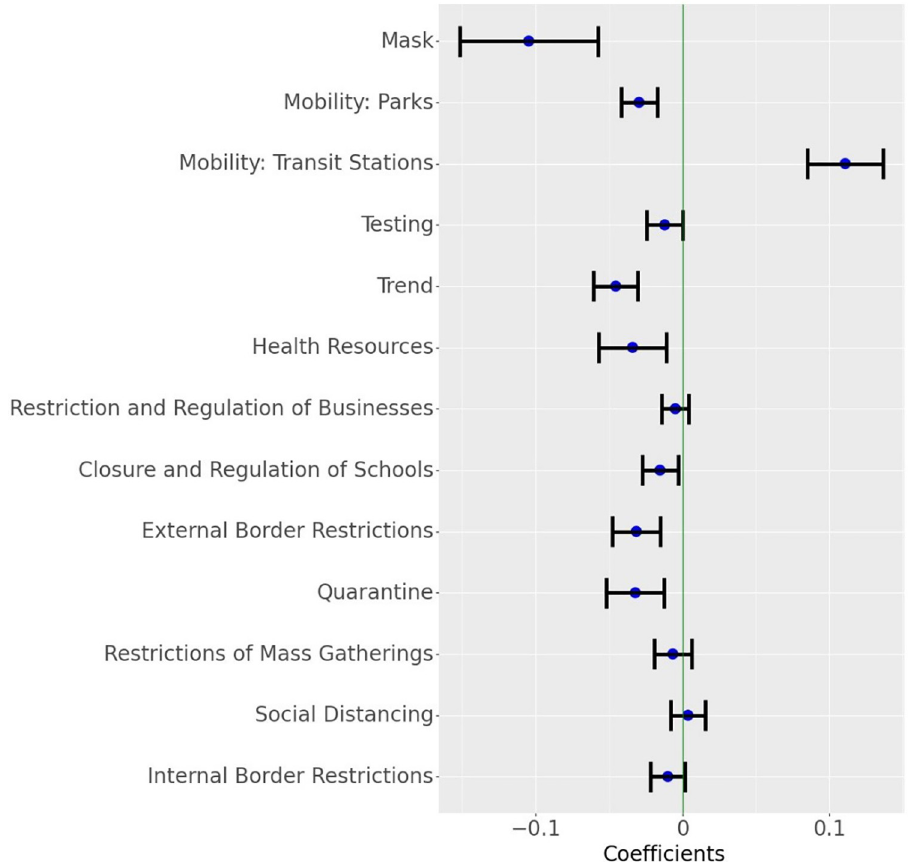
Fig 5. Parameter estimates for the growth rate model. The blue dot indicates the point estimates and the horizontal lines indicate a 95% confidence interval around the estimate (Masks transformed as ln(1+mask)). Results for different transformations of Mask and other covariates are shown in Fig Q in S1